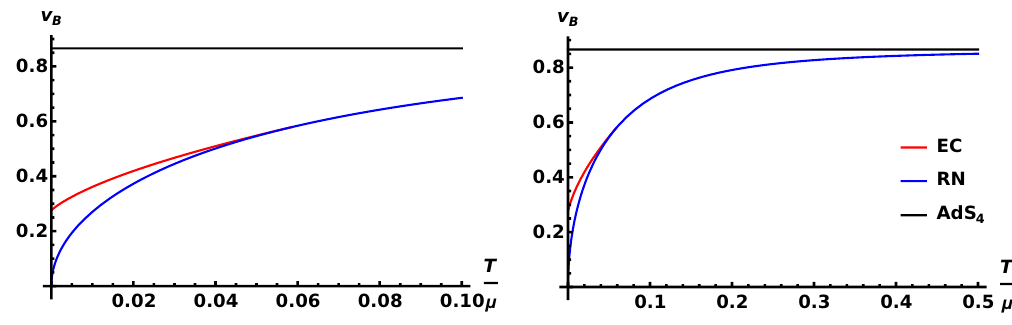
Figure 5 . Left : we depict the butterfly velocity (3.26) as a function of T/µ . Notice that at high temperature we obtain the black brane result p 3 / 4 shown as black line, while below the phase transition the velocity is always higher than that for a AdS-RN background. Right : same quantity as on the left panel, but shown for larger values of T/µ